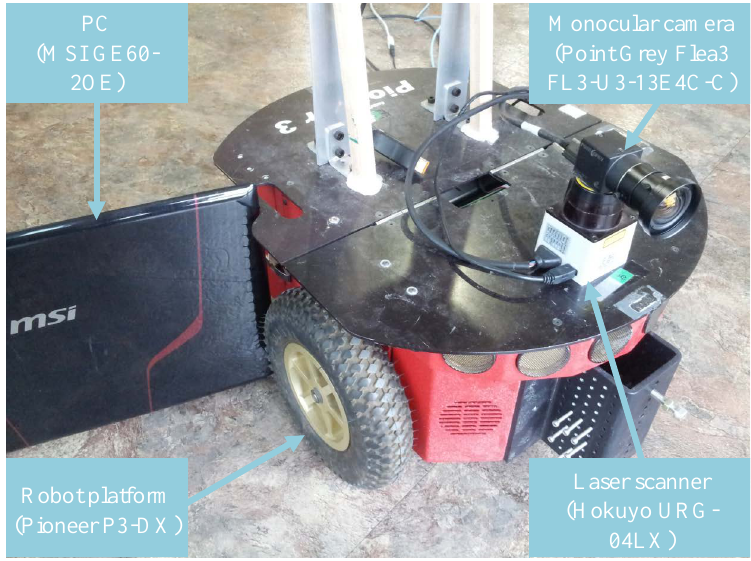
Figure 7. Experimental system. The system consists of Pioneer P3-DX, Hokuyo